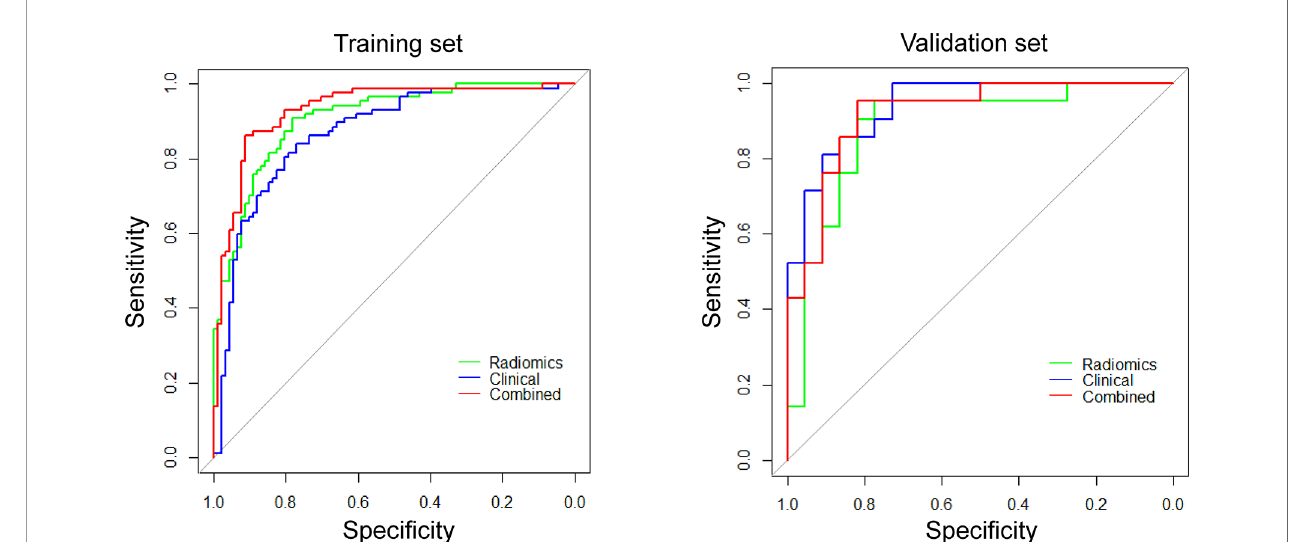
FIGURE 4 | ROC curves for differentiating CD8 expression status of these three models (radiomics, clinical, and combined